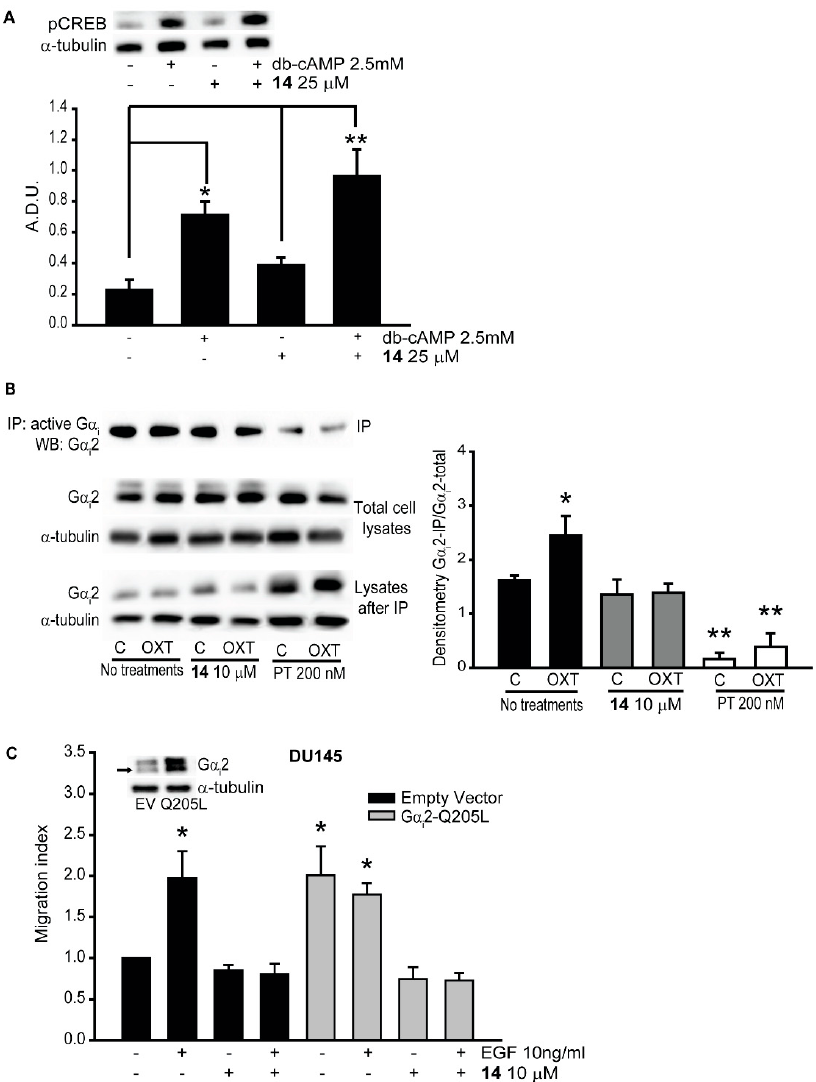
Figure 4. The inhibitors blocked the activation of G α i 2. ( A ) PC3 cells were pre-treated with ( + ) or without ( − ) compound 14 at 25 µ M and then stimulated with ( + ) or without ( − ) dibutyryl-cAMP (dbcAMP) at 2.5 mM. Total cell lysates were subjected to Western blot analysis, using the pCREB (Ser129) antibody. Independent experiments were conducted at least three times, and representative images of immunoblots are shown. Densitometr analysis was performed using ImageJ [24]. ( B ) Total cell lysates from di ff erent treatments were immunoprecipitated using anti-active G α i antibody, and the immunoprecipitates were immunoblotted with anti-G α i 2 antibody. Independent experiments were conducted three times, and representative images of immunoblots are shown. Densitometric analysis was performed using ImageJ [24]. ( C ) Cell migrations in parental DU145-EV and DU145-G α i 2-Q205L cells were performed after incubation with ( + ) or without ( − ) compound 14 at 10 µ M, in presence ( + ) or absence ( − ) of EGF (10 ng / mL). Results are expressed as migration index. Each bar represents mean ± SEM (* p ≤ 0.05; ** p ≤